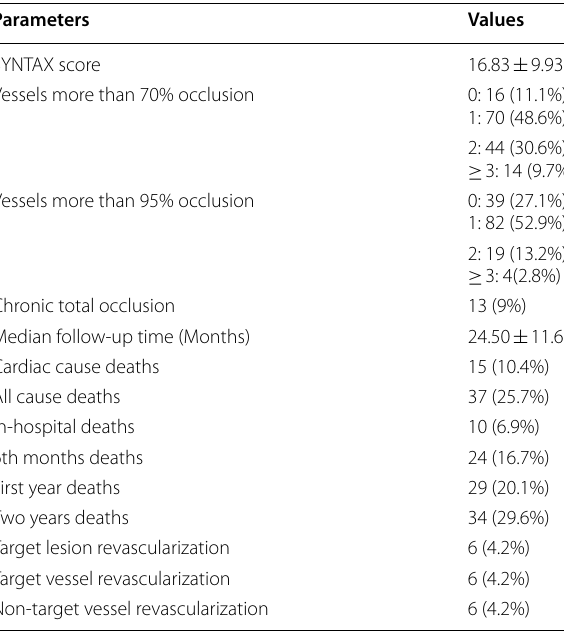
Table 1 Baseline characteristics and laboratory data Parameters